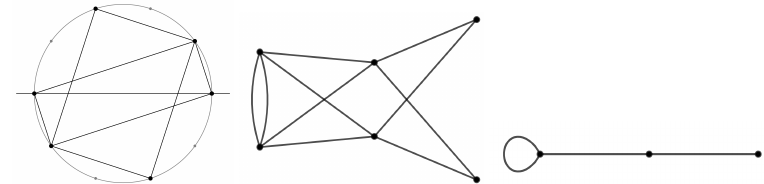
Figure 11. Renderings of G 5 . The left panel is the two-dimensional base space graph. The grey dots represent the members of D p that are not vertices. The grey circle simple guides the eye to the embedding space, S 1 . The middle panel is a different representation of the graph that vertically juxtaposes antipodal vertices. The right rendering is a reduction of the graph by associating antipodal points together as a single vertex. The resulting graphs is A 5 . This always reduces the number of vertices by half.